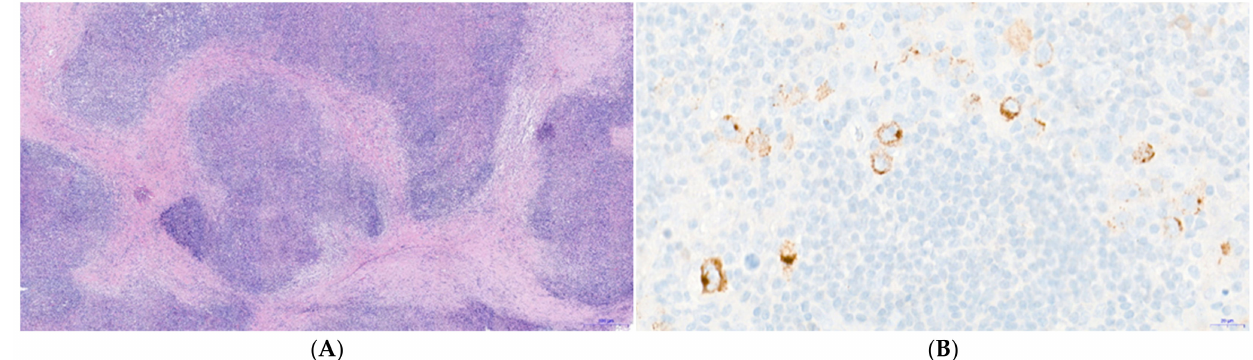
Figure 1. Histopathology of classical Hodgkin lymphoma (cHL) and expression of Epstein–Barr virus Latent-Membrane Protein 1 (EBV-LMP1). ( A ) Hematoxylin-Eosin (H&E) staining showing fibrotic bands that deimitate a nodular pattern in a case of nodular sclerosis cHL (magnification 4 × ) ( B ) Immunohistochemistry for Epstein–Barr Virus Latent Membrane Protein 1 (EBV-LMP1) shows a cytoplasmic and membranous staining in tumoral Hodgkin and Reed–Sternberg (HRS) cells (magnification 20 × ). Positivity for LMP1 is restricted to cells that are cytologically identifiable as part of the tumor clone, i.e., HRS cells. Cells in the inflammatory background (peritumor microenvironment) are shown as negative for LMP1 expression, following the established recommendations for the interpretation of this marker [19].